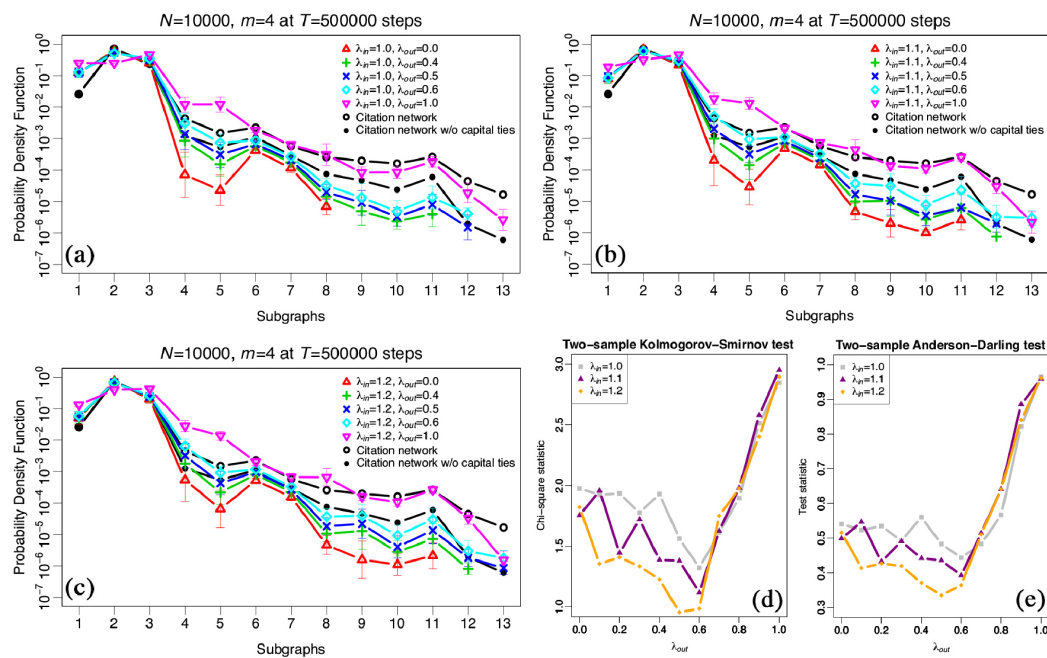
Fig 7. Probability density distributions of subgraphs of network motif generated by the simulation results in a semilog scale plot by N = 10, 000, T = 500, 000, and m = 4. Each panel (a), (b) and (c) shows the distribution by λ in = 1.0, λ in = 1.1 and λ in = 1.2, respectively. Each red triangle, green plus-mark, blue cross, light-blue rhombus, pink descending triangle, black circle, and black filled circle show the result by λ = 0.0, λ = 0.4, λ = 0.5, λ = 0.6, λ = 1.0, the citation network in 2018, and the citation out out out out out network without capital ties, respectively. Each panel (d) and (e) shows the results of the two-sample Kolmogorov–Smirnov test and Anderson–Darling test between real data and the simulation results, respectively. Both horizontal lines show λ , and each vertical out line shows the chi-square statistic and the test statistic as defined above, respectively. Each grey filled square, purple filled triangle, and orange filled rhombus shows λ = 1.0, λ = 1.1, and λ = 1.2, respectively. in in in